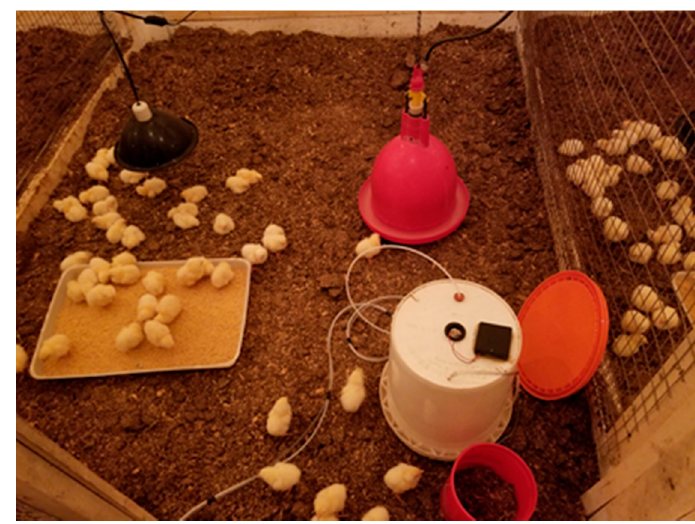
Figure 1. Photograph showing one of the pens used in the study.